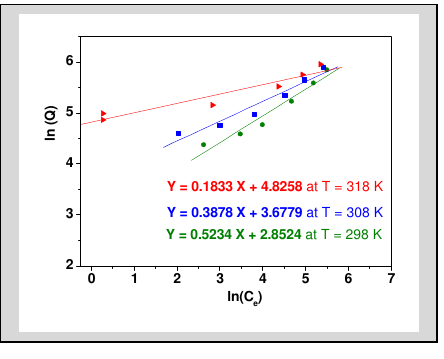
Fig. 10. Freundlich linear plot at 298 K, 308 K and 318 K. Table 3. Parameters of Freundlich and Langmuir analysis of the isotherms at three